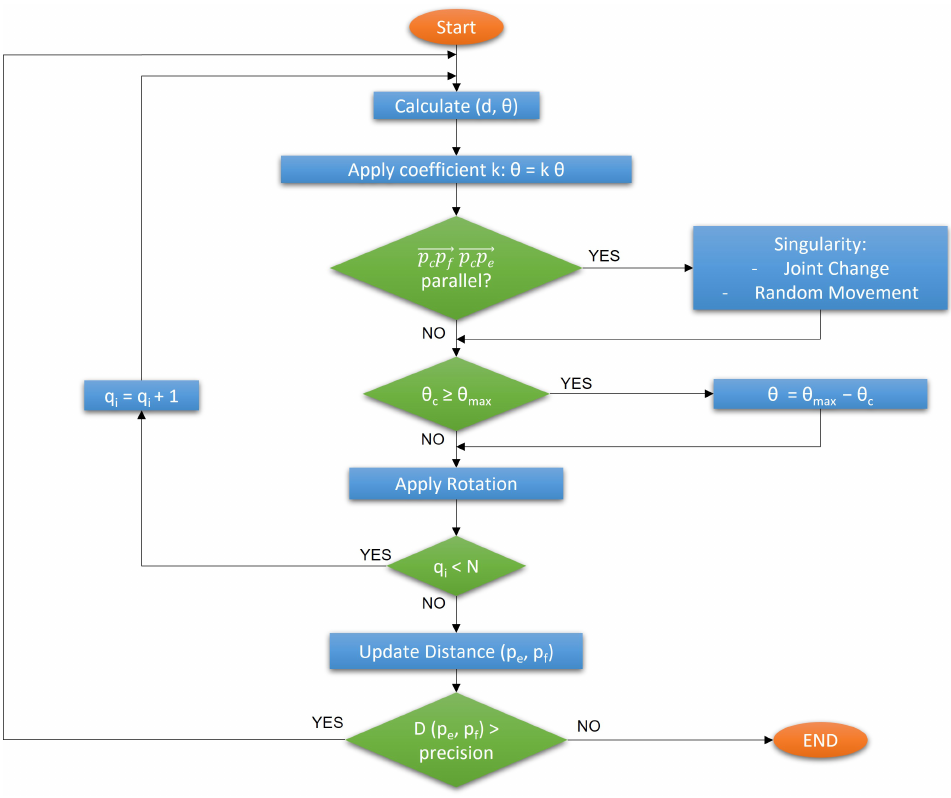
Figure 21. Graphical summary for the Natural-CCD algorithm, produced based on